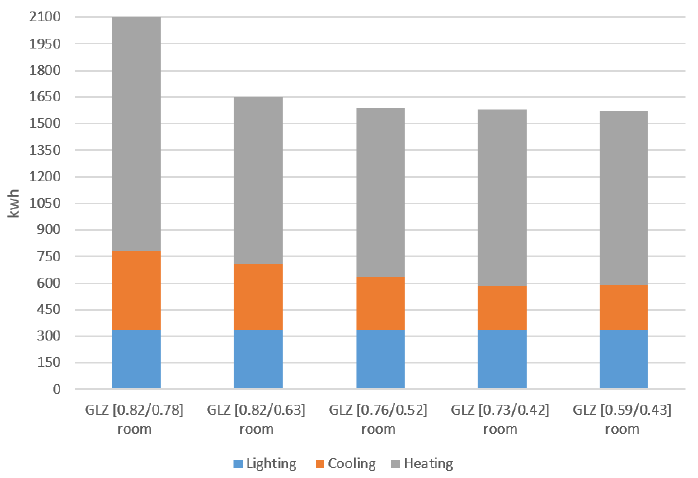
Fig. 5 Annual energy loads of the patient rooms without daylight-linked lighting